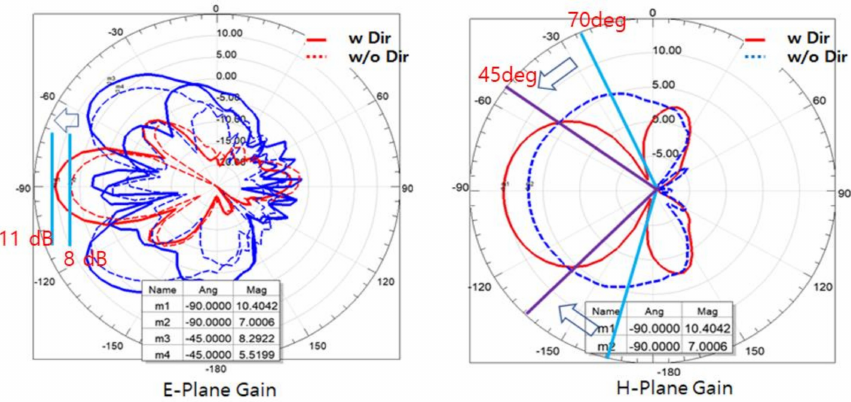
Figure 13. Measurement results of the beam gain with a parasitic array